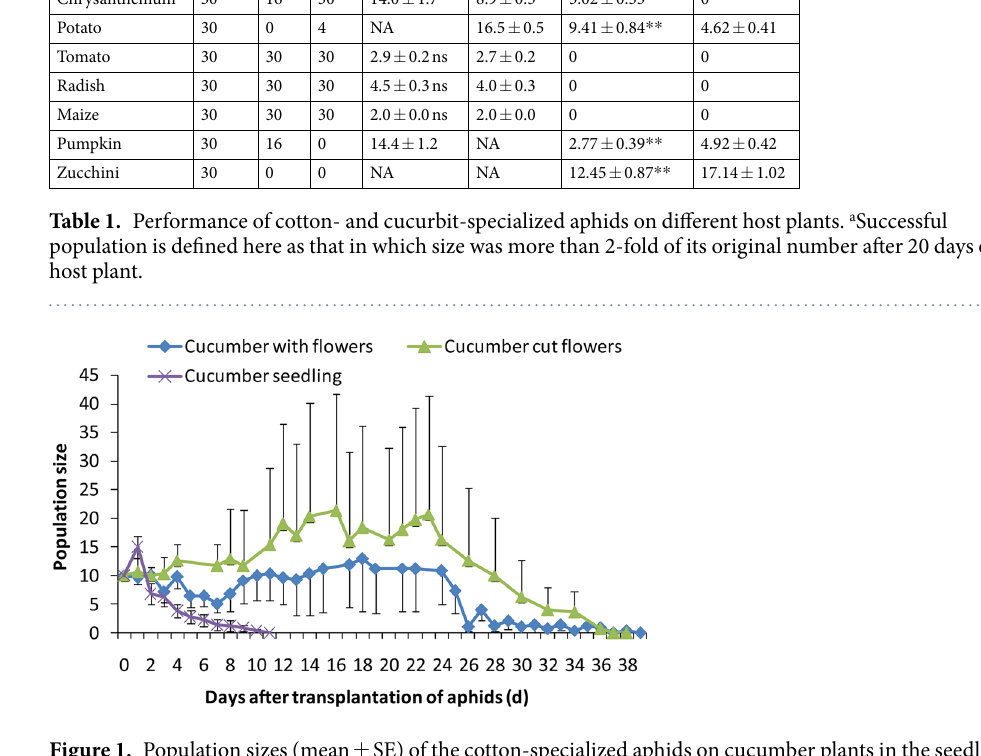
Figure 1. Population sizes (mean ± SE) of the cotton-specialized aphids on cucumber plants in the seedling and flowering